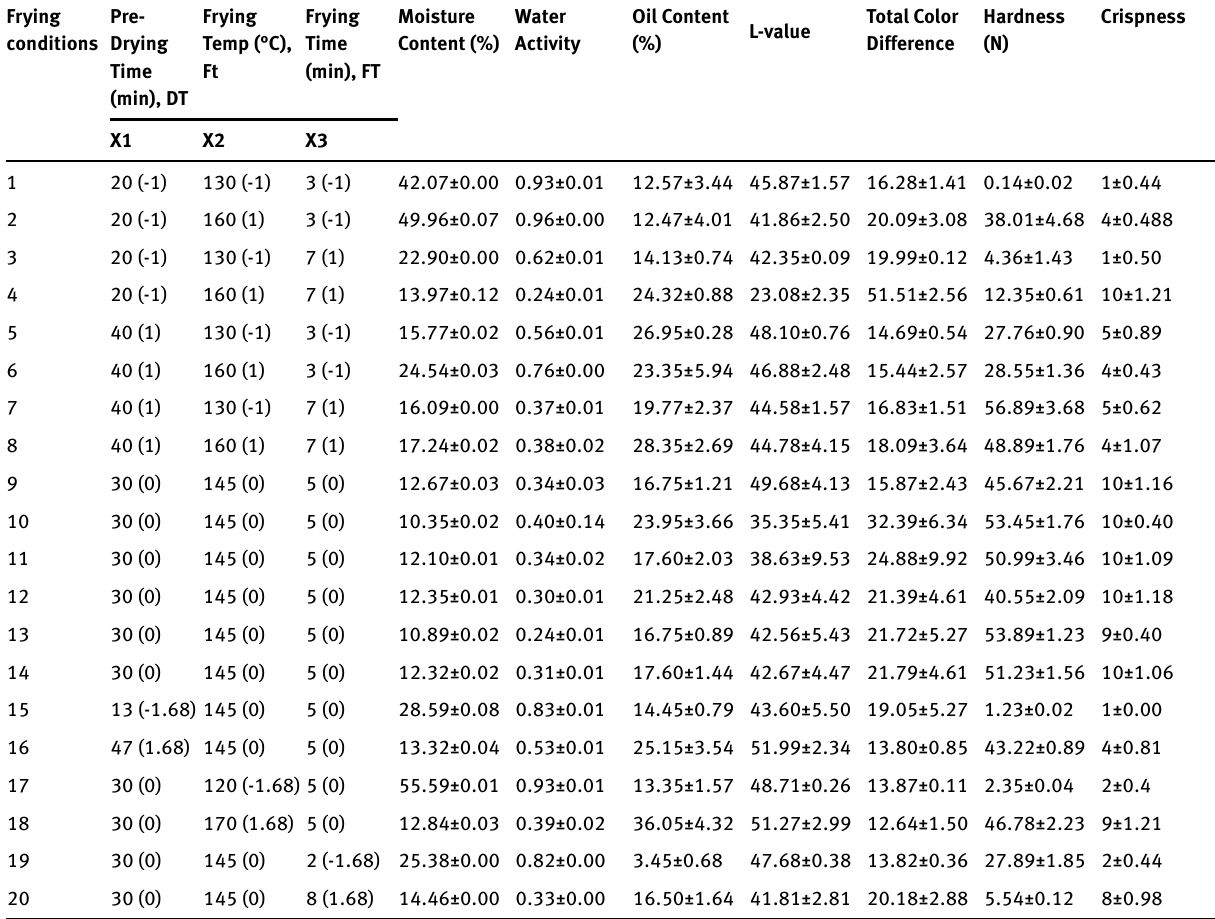
Figure 1: A flow chart of processing of sweet potato chips Table 1 : Experimental design (CCRD) of sweet potato chips processing conditions and the experimental results of moisture content, water Figure 1 : A flow chart of processing of sweet potato chips activity, oil content, L value, total color difference, hardness and crispness of different fried sweet potato